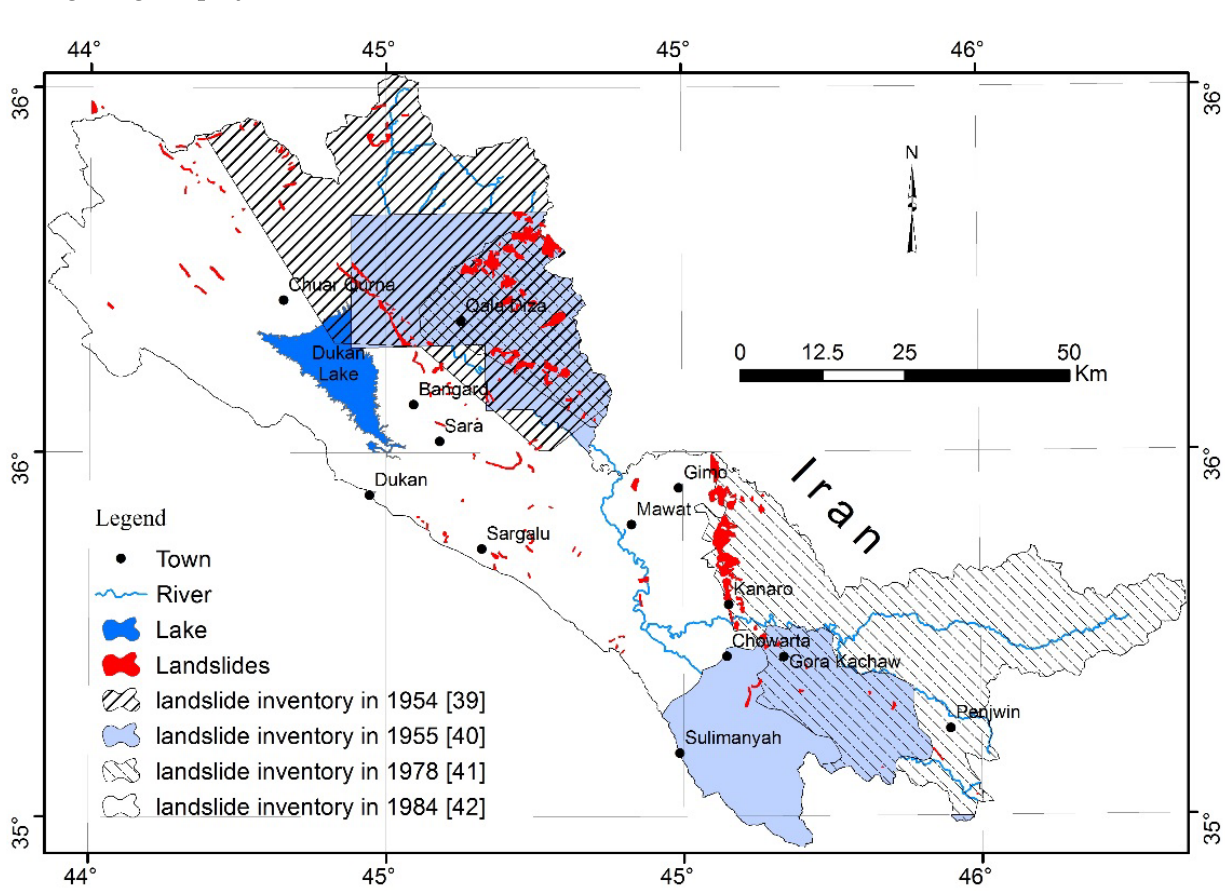
Figure 6. The inventory map of the 196 major landslides digitized from previous geological projects